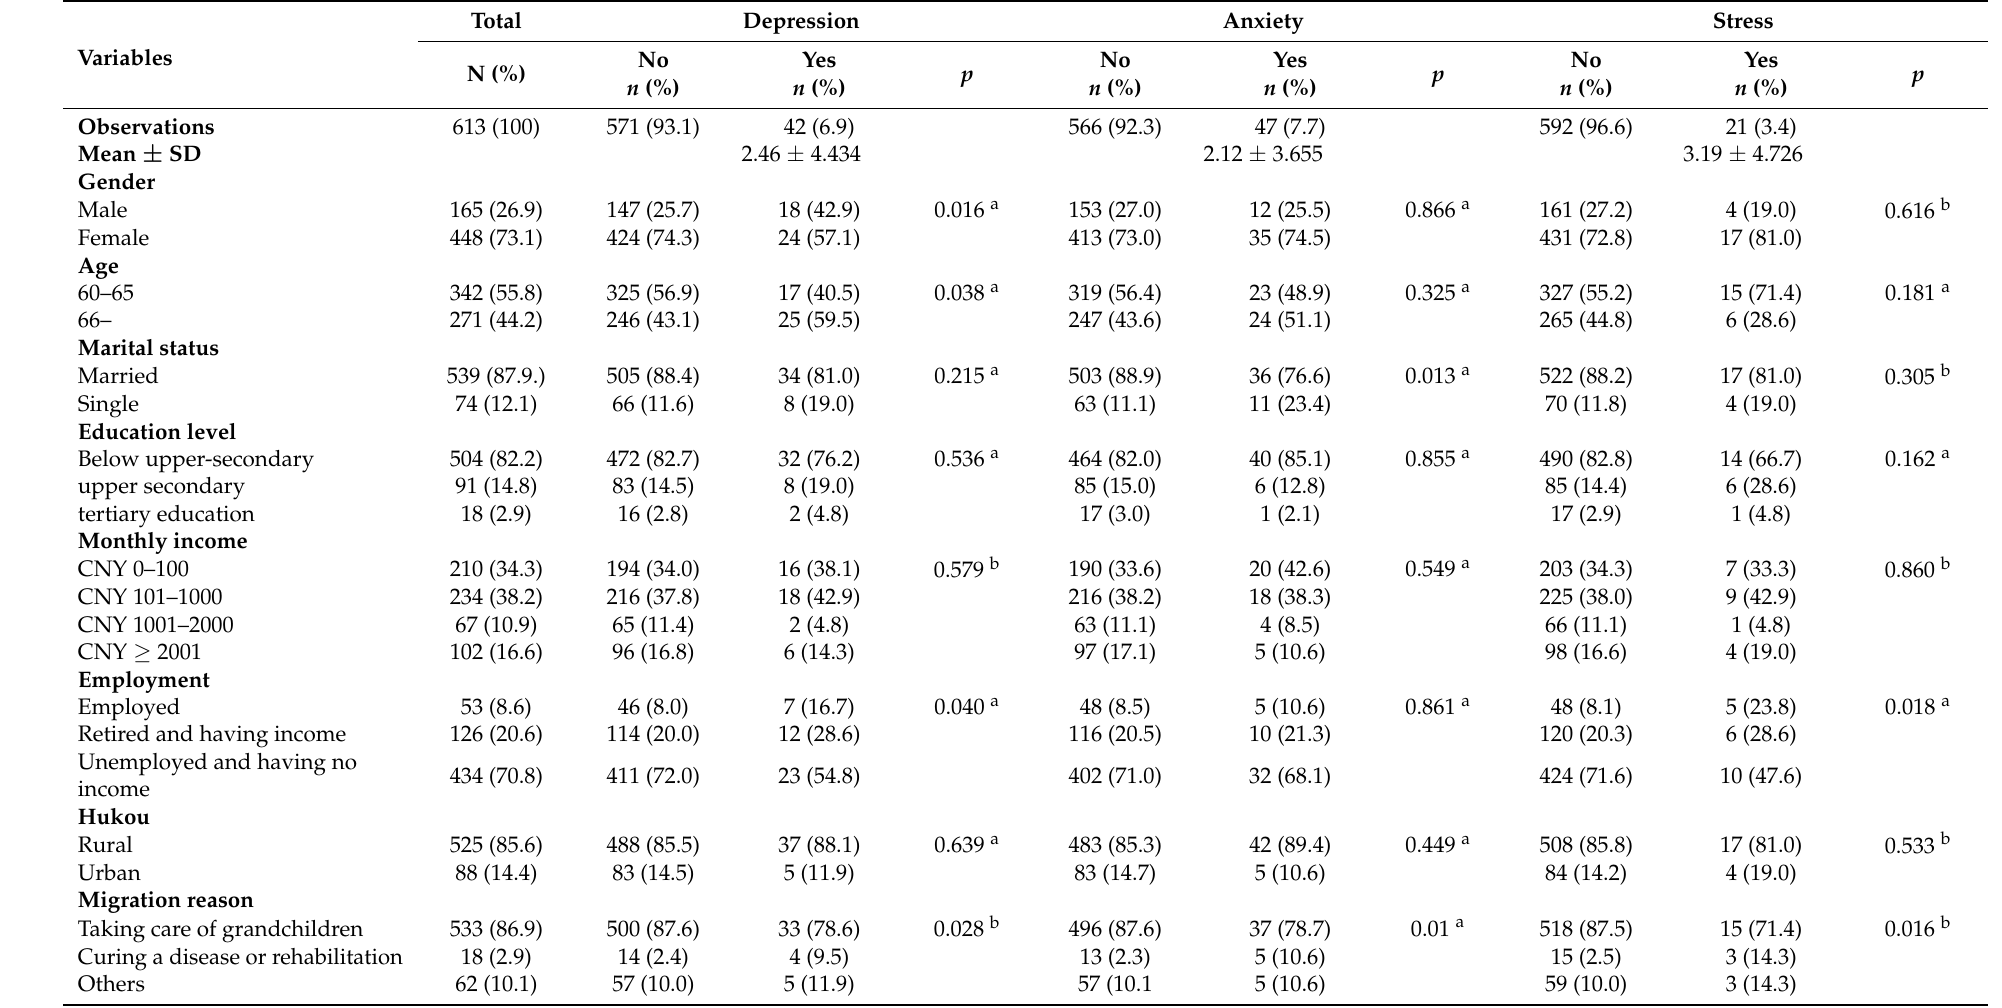
Table 1. Descriptive analysis of the general characteristics of IMEFC by depression, anxiety and